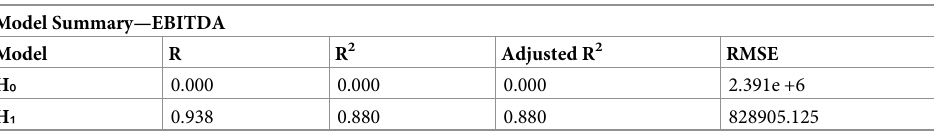
Table 13. Model Summary–EBITDA.